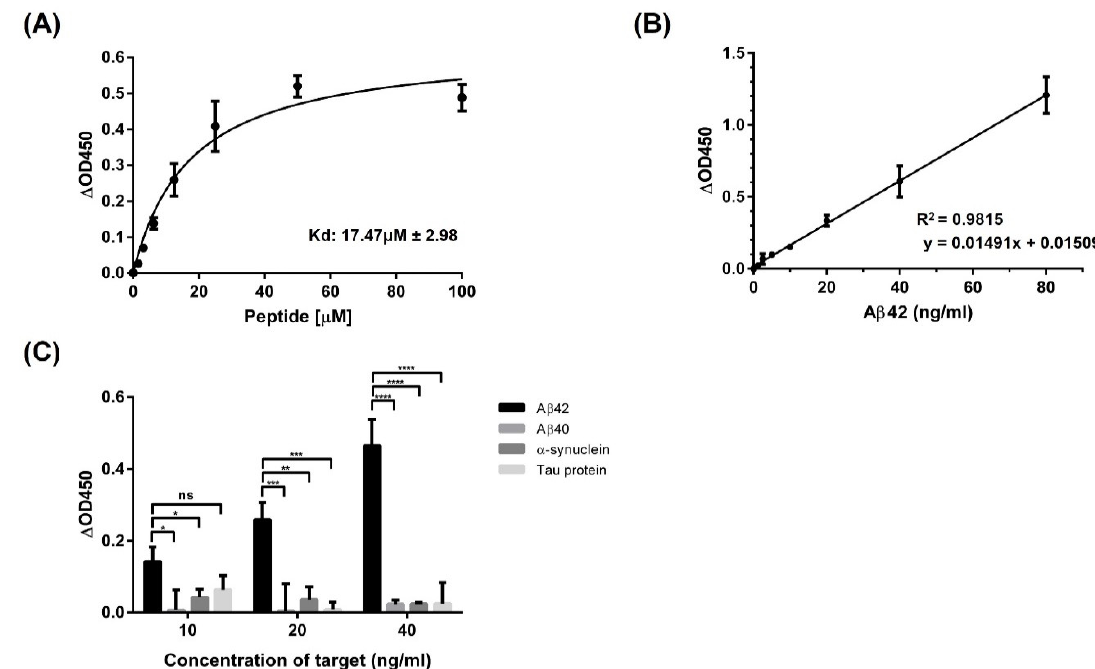
Figure 2. Characterization of binding of the screened peptide. ( A ) The peptide showed strong binding affinity in the micromolar range with a K D of 17.47 ± 2.98 µ M. ( B ) Linear regression of binding between A β 42 and ABPP ( R 2 = 0.9815). ( C ) Specificity test on an anti-A β 42 antibody–coated plate. Only A β 42 showed meaningful signals. One-way ANOVA analysis was performed for statistical analysis (ns p > 0.05, * p ≤ 0.05, ** p ≤ 0.01, *** p ≤ 0.001, **** p ≤ 0.0001). All tests were performed in triplicate under the same conditions.